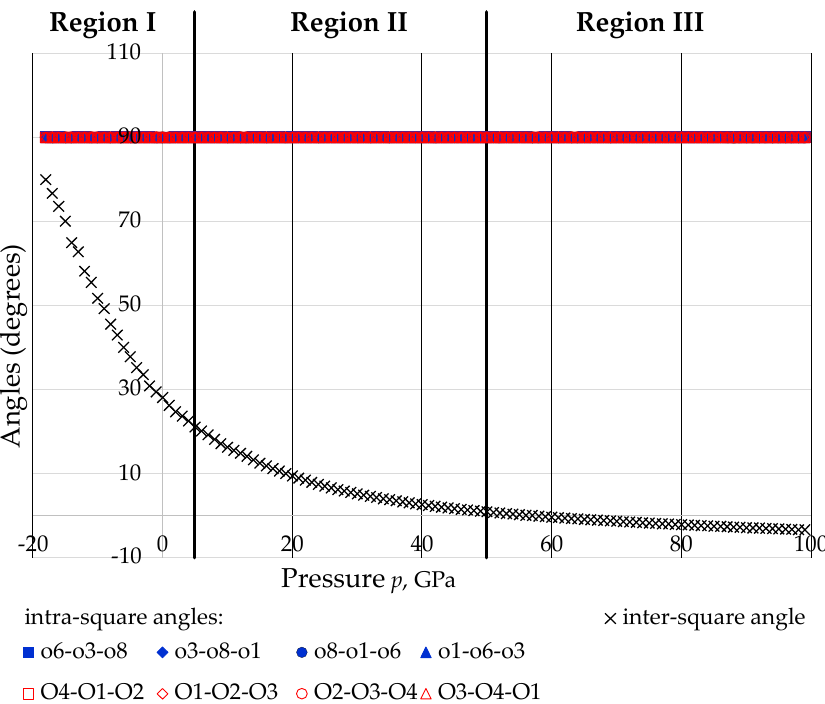
Figure 11. The variation with pressure p of the intra and inter-square angles with the intra-square angles remaining practically constant at 90 ◦ throughout the whole range of applied pressures, whilst the inter-square angle tending to 90 ◦ at high negative pressures (‘fully open’ conformation) and to 0 ◦ (‘fully closed’ conformation) at extreme positive pressures. Note that at p = 10 GPa, the inter-square angle had already decreased to just c. 16 ◦ and at p > c. 58 GPa, the inter-square angle is less than 0 ◦ . This may be permitted since the tetrahedra which project as squares occupy different ‘depth’ down the c -direction, i.e., do not physically overlap.